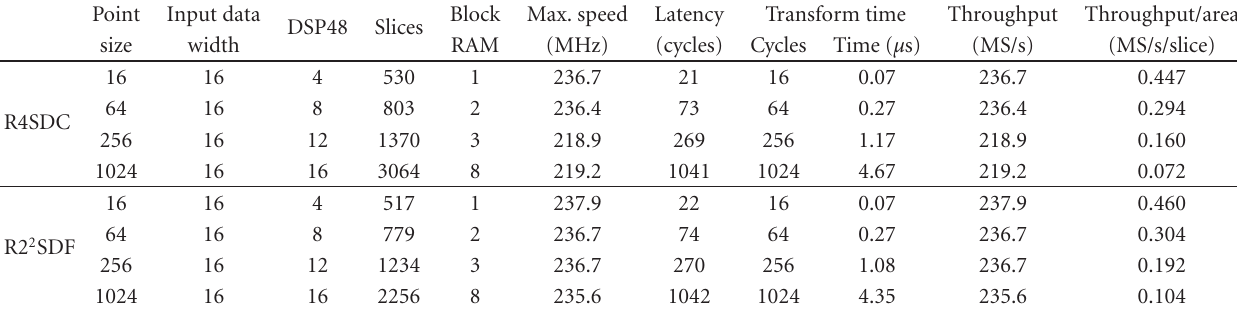
Table 5: Implementation results on Virtex-4 devices.